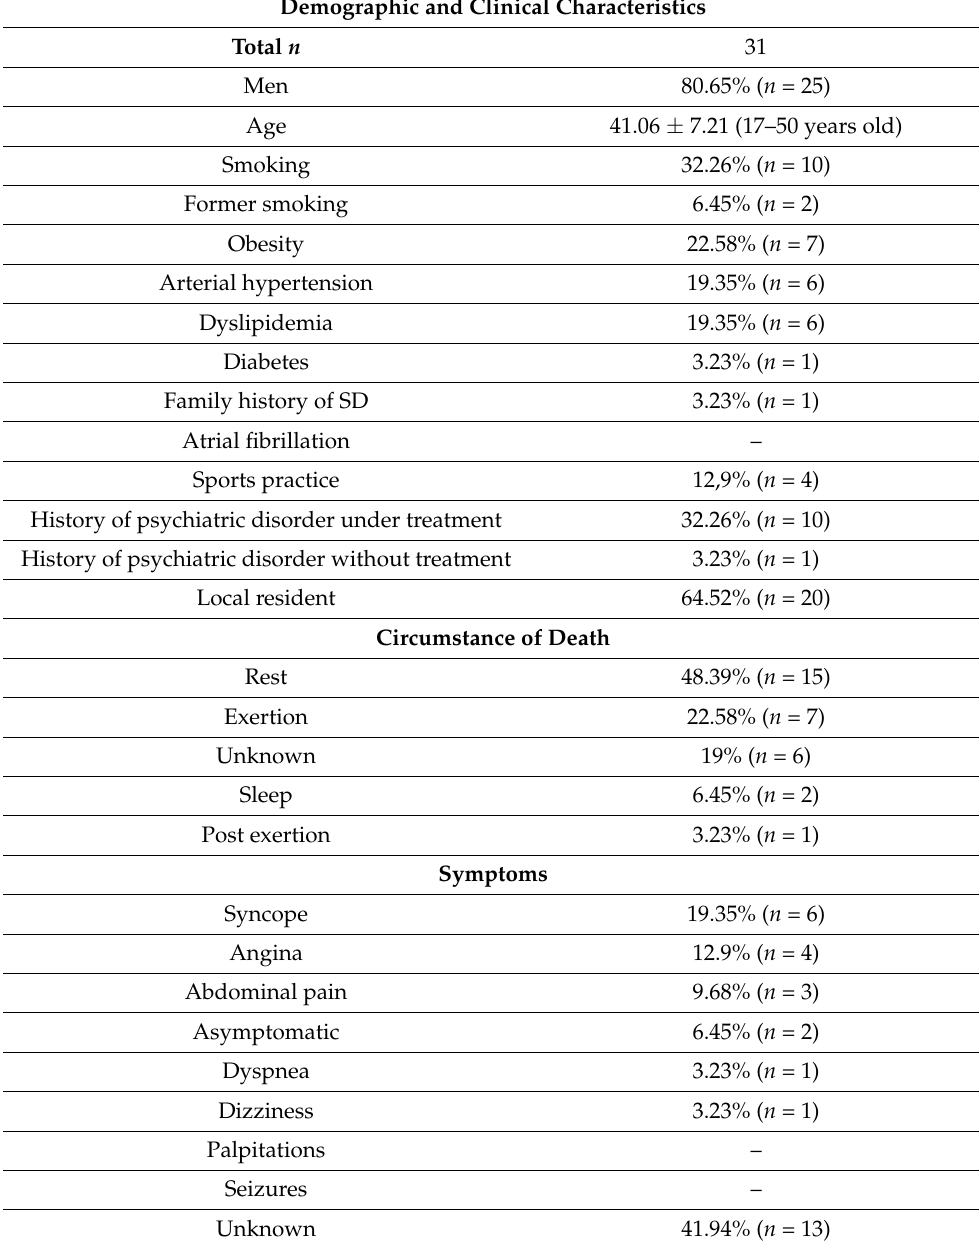
Table 1. Demographic and clinical characteristics of decedents. SD, sudden